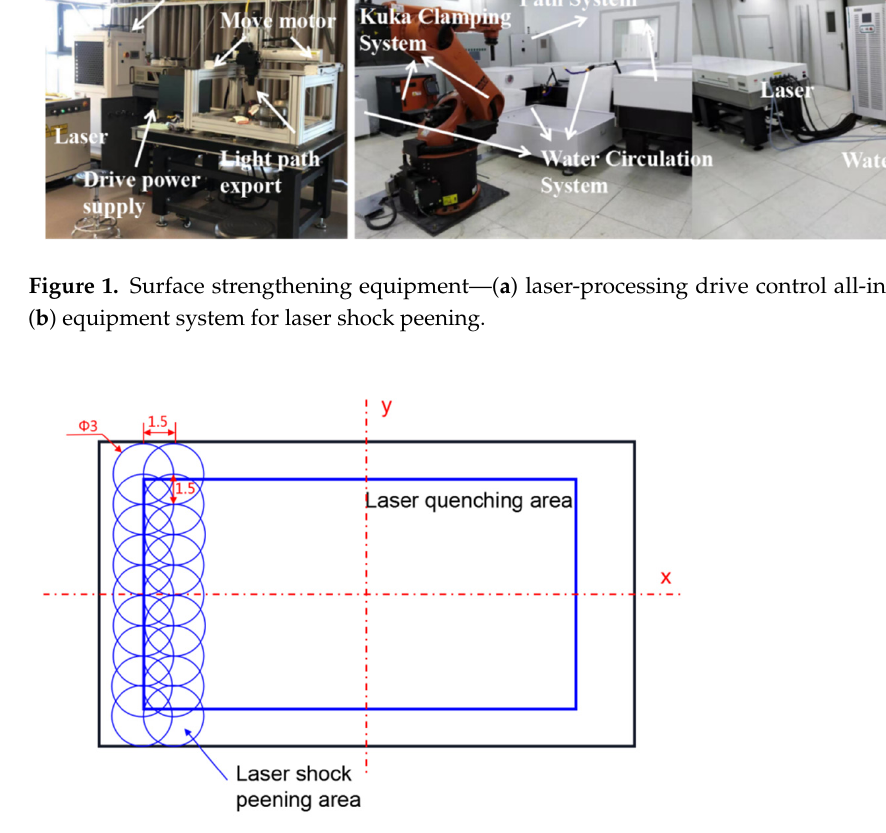
Figure 2. Design of laser quenching–shock peening strengthening experiment scheme.